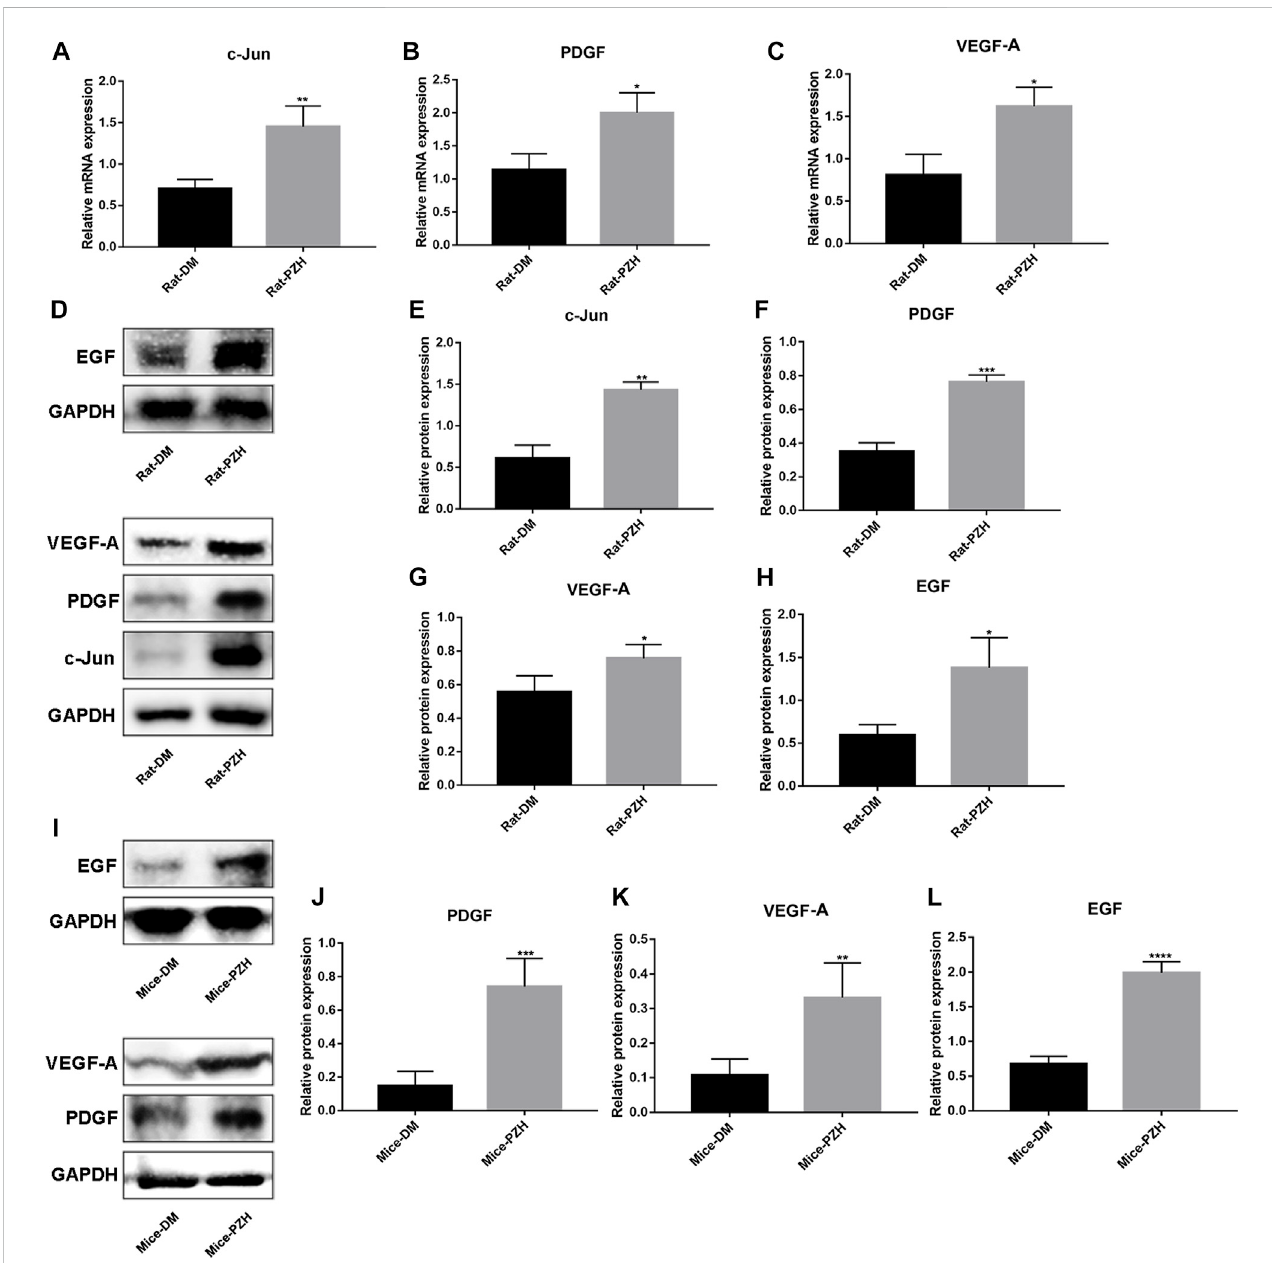
FIGURE 3 PZHincreasedtheexpressionofgrowthfactorsindiabeticwounds. (A – C) EffectoftopicaltreatmentwithPZHontheeighthdayofwoundhealingatthe mRNA levels of c-jun (A) , PDGF (B) , and VEGF-A (C) in diabetic rat wounds. * p < 0.05, ** p < 0.01 (n = 3). (D – H) The protein level of c-jun, VEGF-A, PDGF, and EGF was detected in type 1 diabetic rat wounds on the eighth day of topical treatment with PZH, (D) is representative blotting, band intensity was quanti fi ed using ImageJ, right panels are quanti fi cation of c-jun (E) , PDGF (F) , VEGF-A (G) and EGF (H) level, * p < 0.05, ** p < 0.01, *** p < 0.001 (n = 3). (I – L) The protein level of PDGF (J) , VEGF-A (K) , and EGF (L) were detected in type 2 diabetic mouse wounds on the 10th day of PZH gavage treatment by Western blotting, and band intensity was quanti fi ed using ImageJ, (I) is representative blotting. * p < 0.05, ** p < 0.01 (n = 4). Data are expressed as the mean ± SD. DM: diabetic control group; PZH: PZH-treated group.